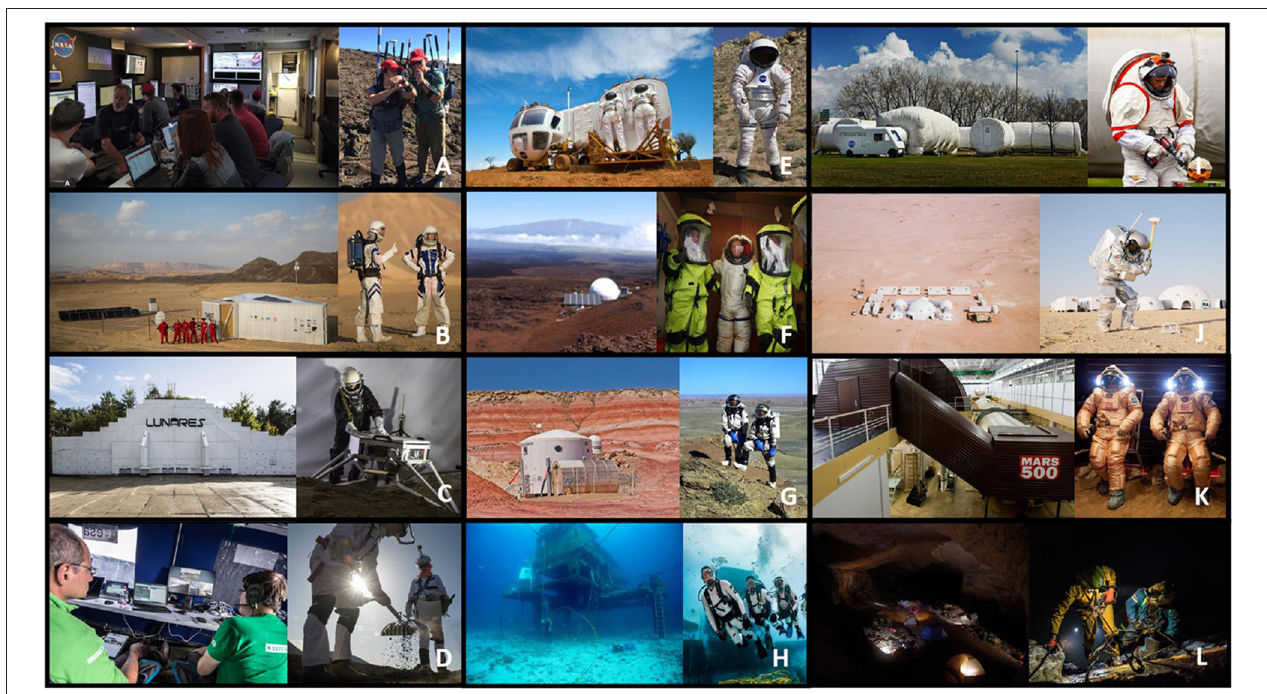
FIGURE 1 | Examples of analog missions. (A) NASA BASALT (USA), (B) D-MARS (Israel), (C) LUNARES (Poland), (D) ESA/PANGEA (Spain), (E) NASA/D-RATS (USA), (F) HI-SEAS (USA), (G) Mars Desert Research Station (USA), (H) NASA/NEEMO underwater station (USA), (I) NDU Habitat Demonstrator (USA), (J) OeWF/AMADEE-program (Austria, Oman), (K) Mars-500 (Russia), and (L) ESA/CAVES (Spain/Italy). Image credits: (A) photos with permission from Zara Mirmalek, (B) photos with permission from Hilel Rubinstein/D-MARS, (C) photos with permission from Anna B. Gregorczyk, (D) photos from permission from ESA/S. Sirios, (E) photos NASA, (F) photos with permission from Ross Lockwood, (G) photos with permissions from OeWF, (H) photos: NASA/Florida International University, (I) photos with permission from Pablo de Leon, University of North Dakota, (J) photos with permission from OeWF, (K) photos: Roskosmos, (L) photos: European Space